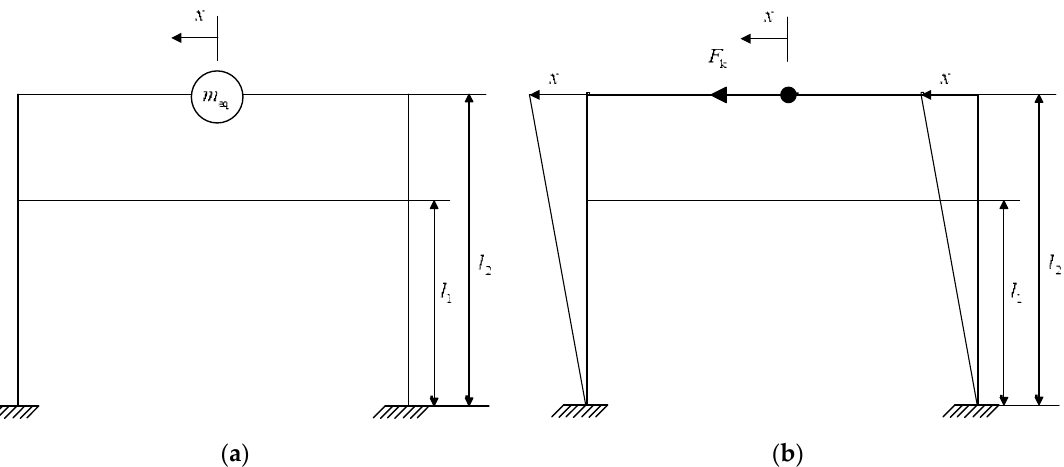
Figure 11. ( a ) One degree of freedom (1-DOF) model of the machine; ( b ) frame model used to calculate the stiffness to the horizontal displacement from the equivalent mass.